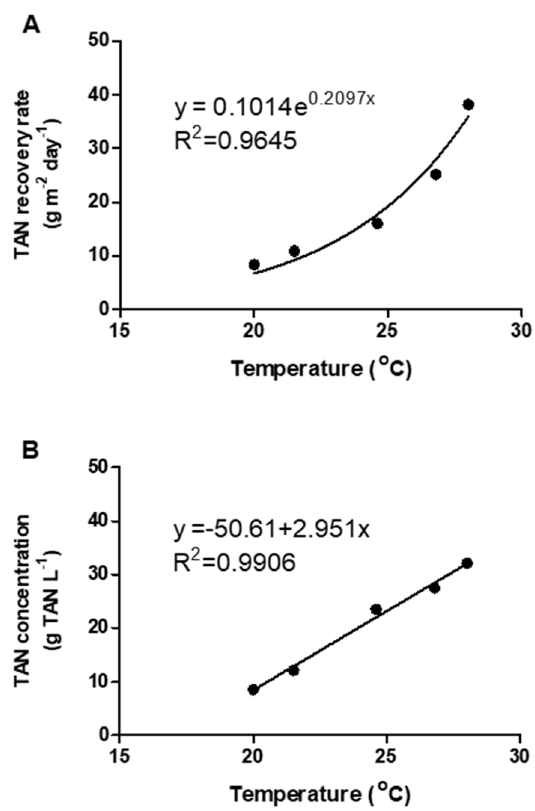
Figure 5. Relationships between ( A ) raw swine manure temperature and total ammonia nitrogen (TAN) recovery rate, and ( B ) raw swine manure temperature and TAN concentration in the acidic trapping solution.